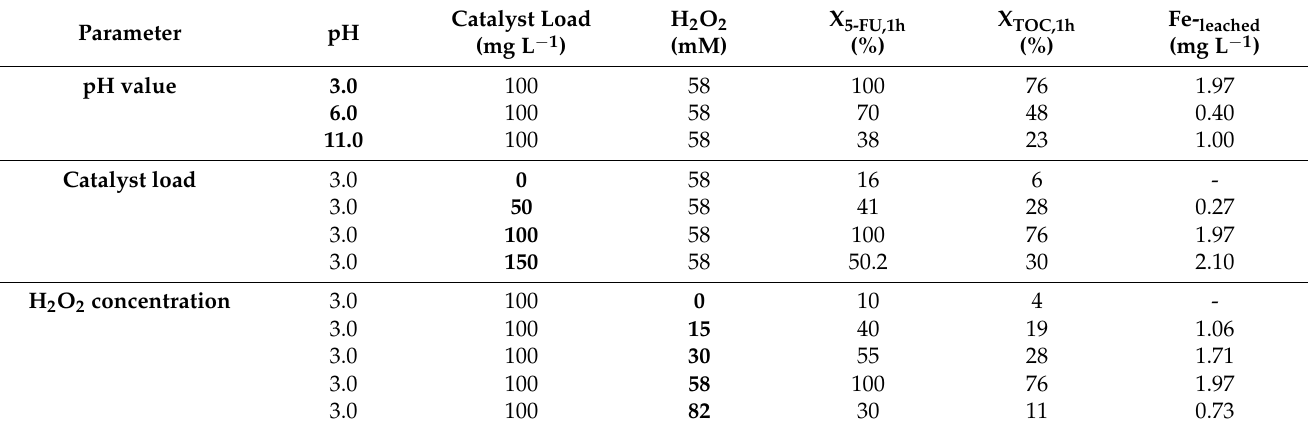
Table 1. Different experimental conditions used in the solar photo-Fenton experiments for the 5-FU degradation and respective Fe-leached and TOC conversion after 1 h of reaction.